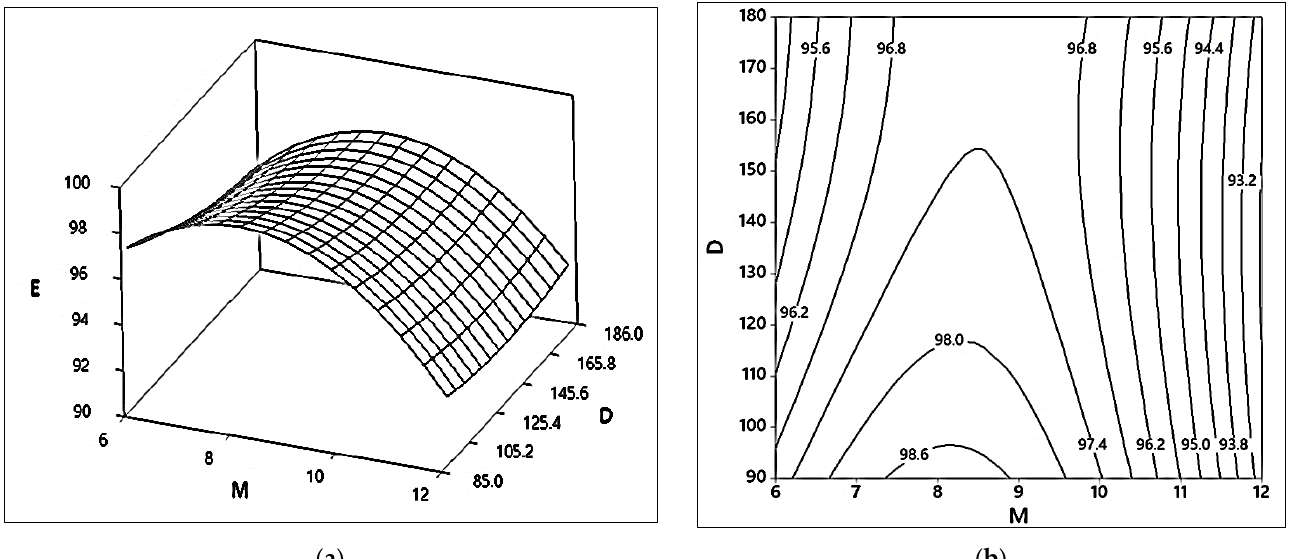
Figure 4. Interaction effect of the methanol to oil molar ratio and reaction temperature on the acidity removal of the WCO esterification process. ( a ) A 3D response surface plot of E (%) vs. M (M) and D (minutes). ( b ) A 2D contour plot between M (M) and D (minutes).